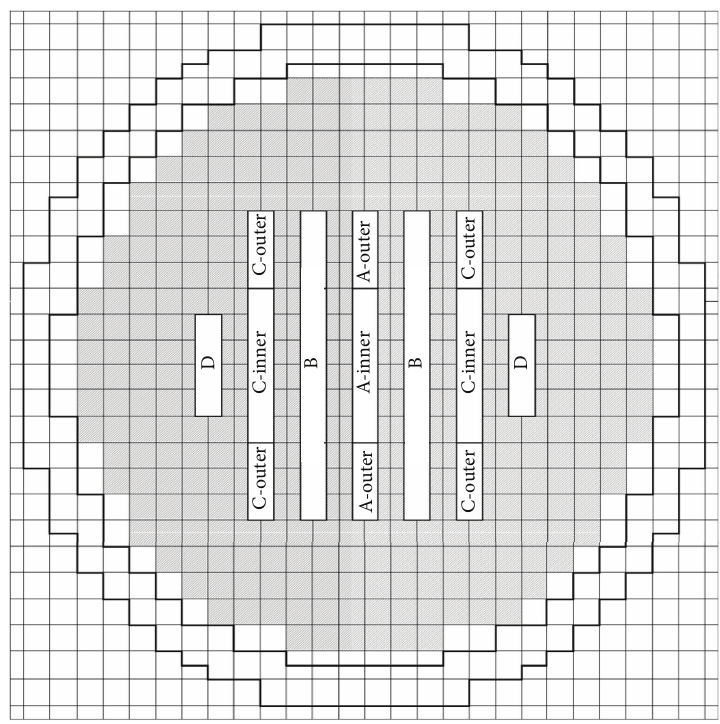
Figure 4: Front view of the CANDU 6 core showing ADJs.